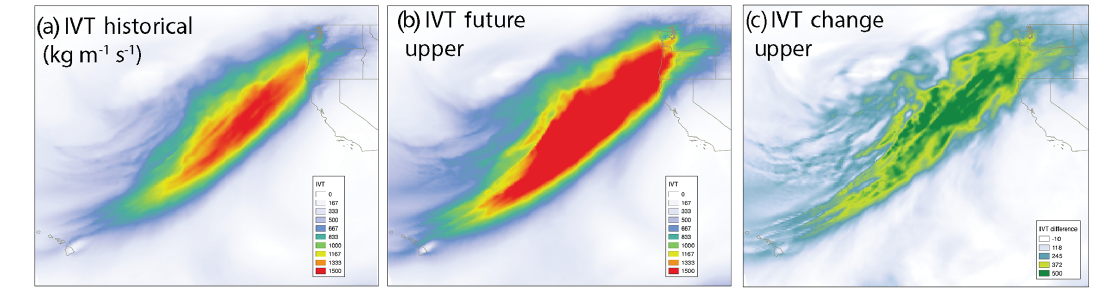
throughout the WRF inner domain. The inner domain